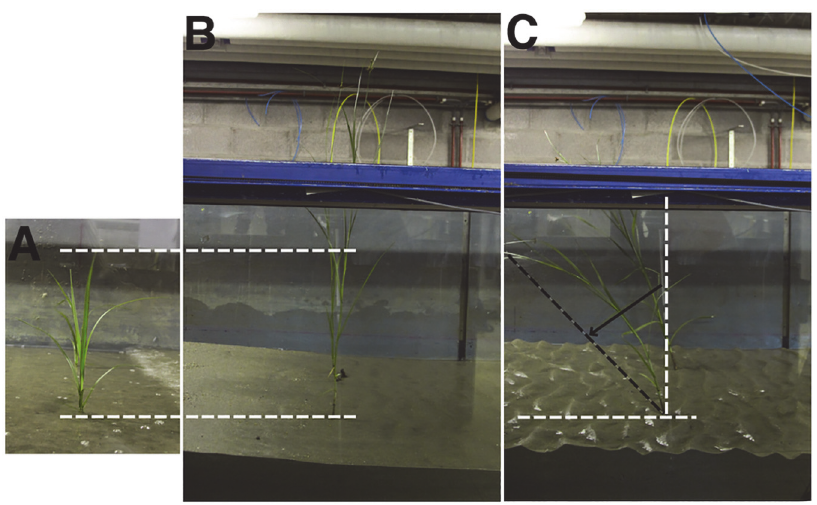
Fig 2. Plant material and definition of bending angle. Seedling (A) and adult shoot (B) of S . maritimus before the wave impact. The horizontal dashed lines indicate the size of the seedling relative to the adult. (C) illustrates how the bending angle (indicated by the black arrow) of the plants was calculated. Vertical white dashed line: stem position before the test; black dashed line: bending of stem after the test.